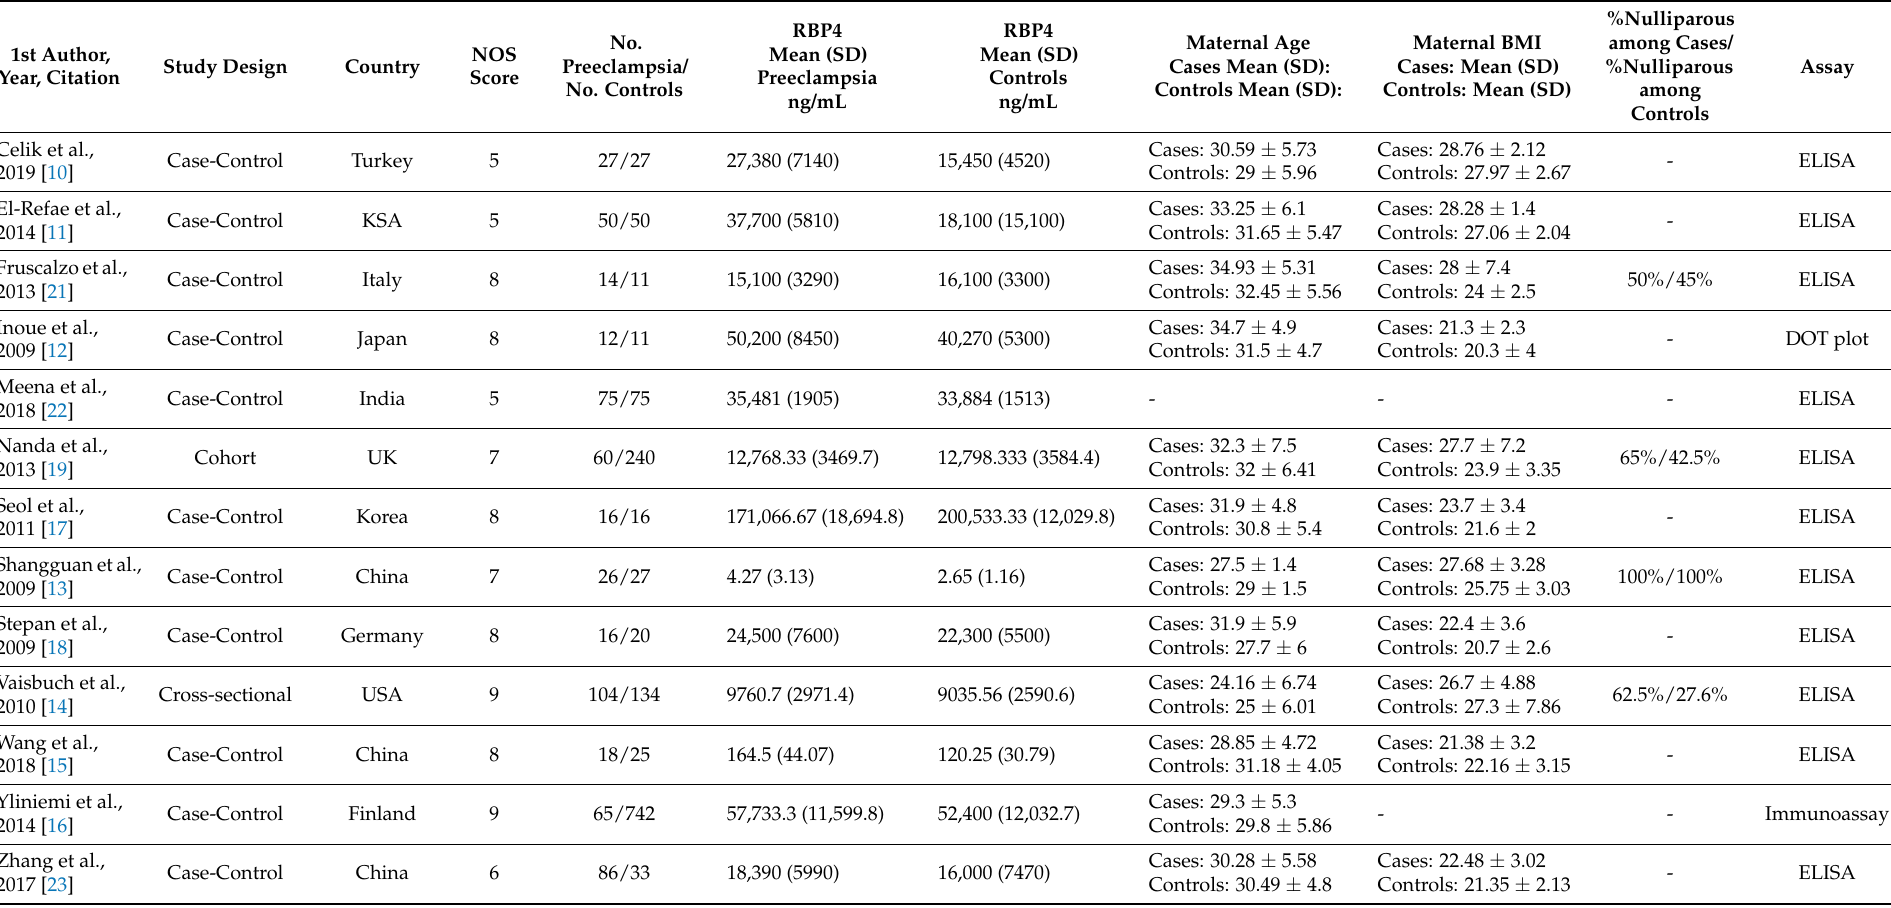
Table 1. Study characteristics included in the